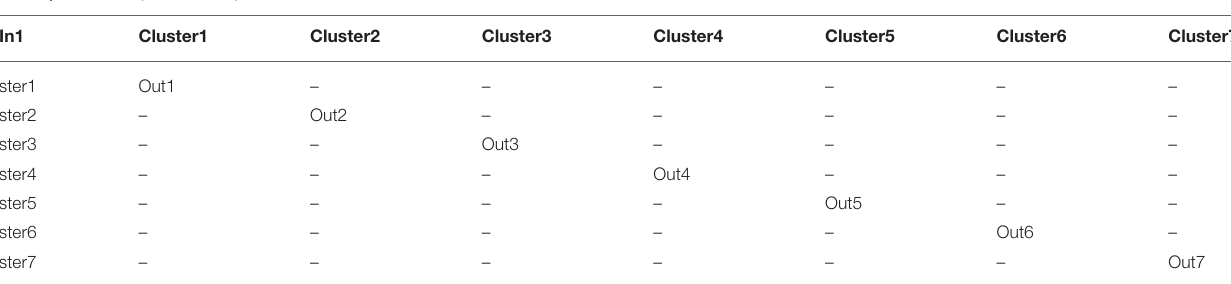
TABLE 2 | Neuro-fuzzy inference system rules.